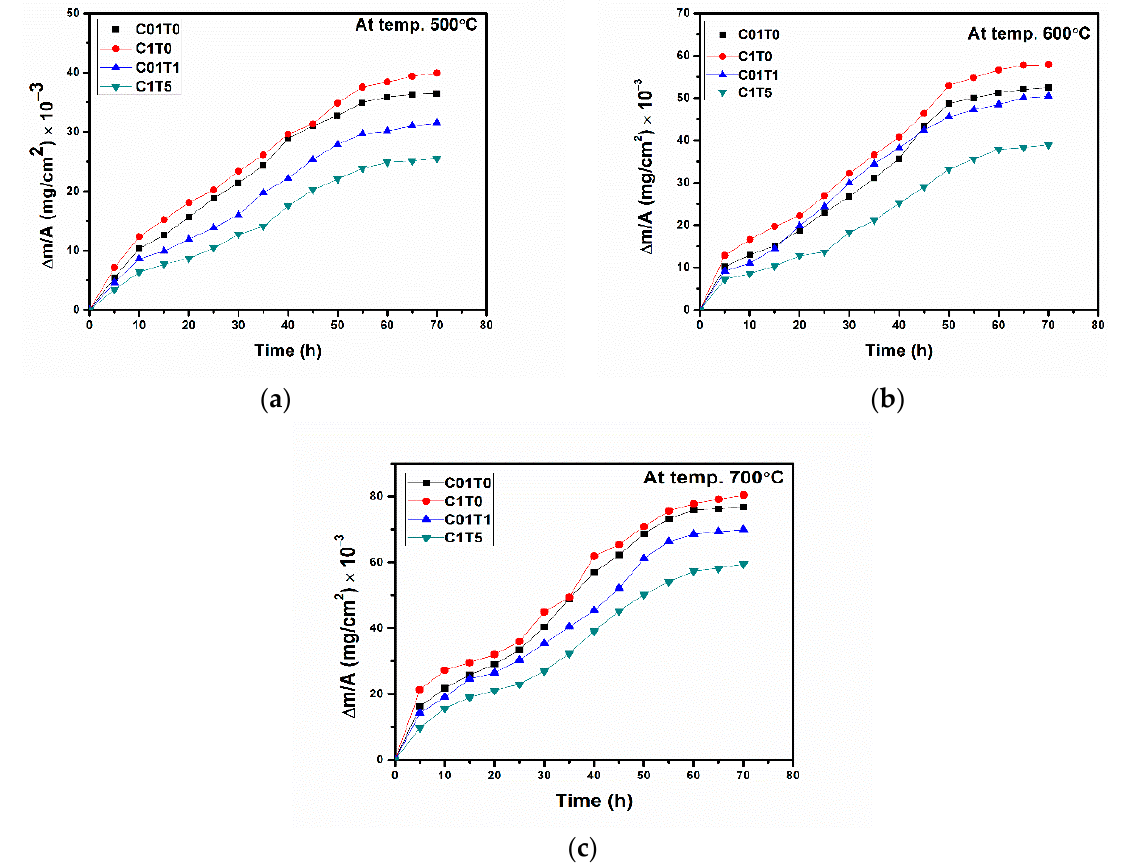
Figure 3. Variation of the weight gain of FeAl-based alloys with time at exposure of temperature ( a ) 500 °C, ( b ) 600 °C, and ( c ) 700 °C (lines joining the data points are for visual aid only).